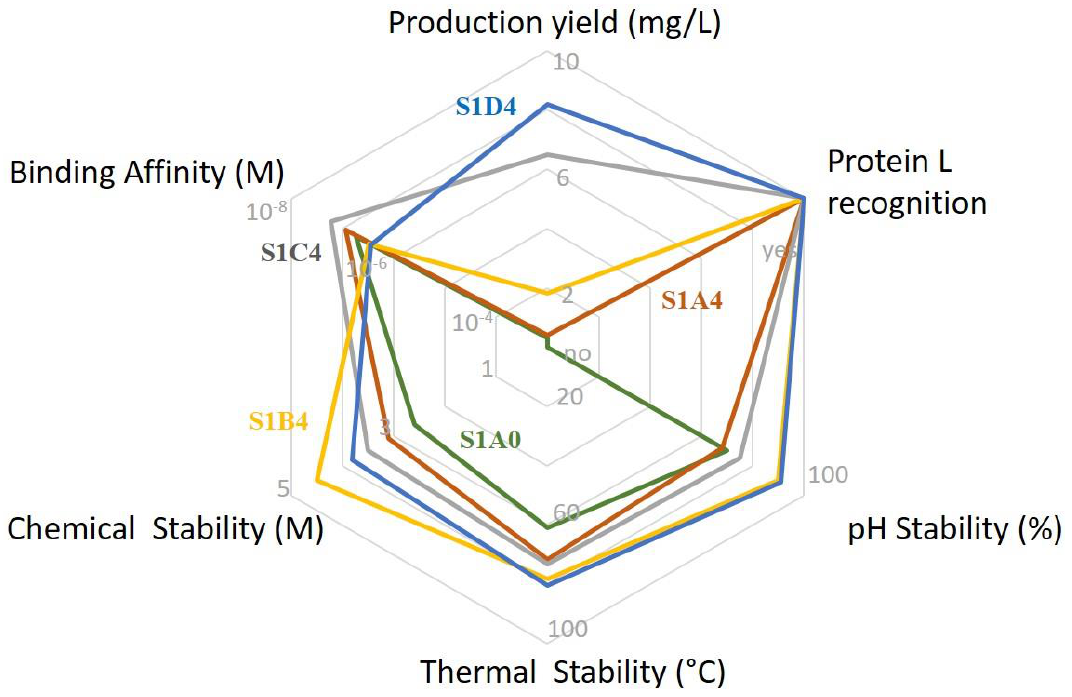
Figure 8. Spider graph representation of all parameters analyzed for wild-type scFv S1A0 and four scFv variants.